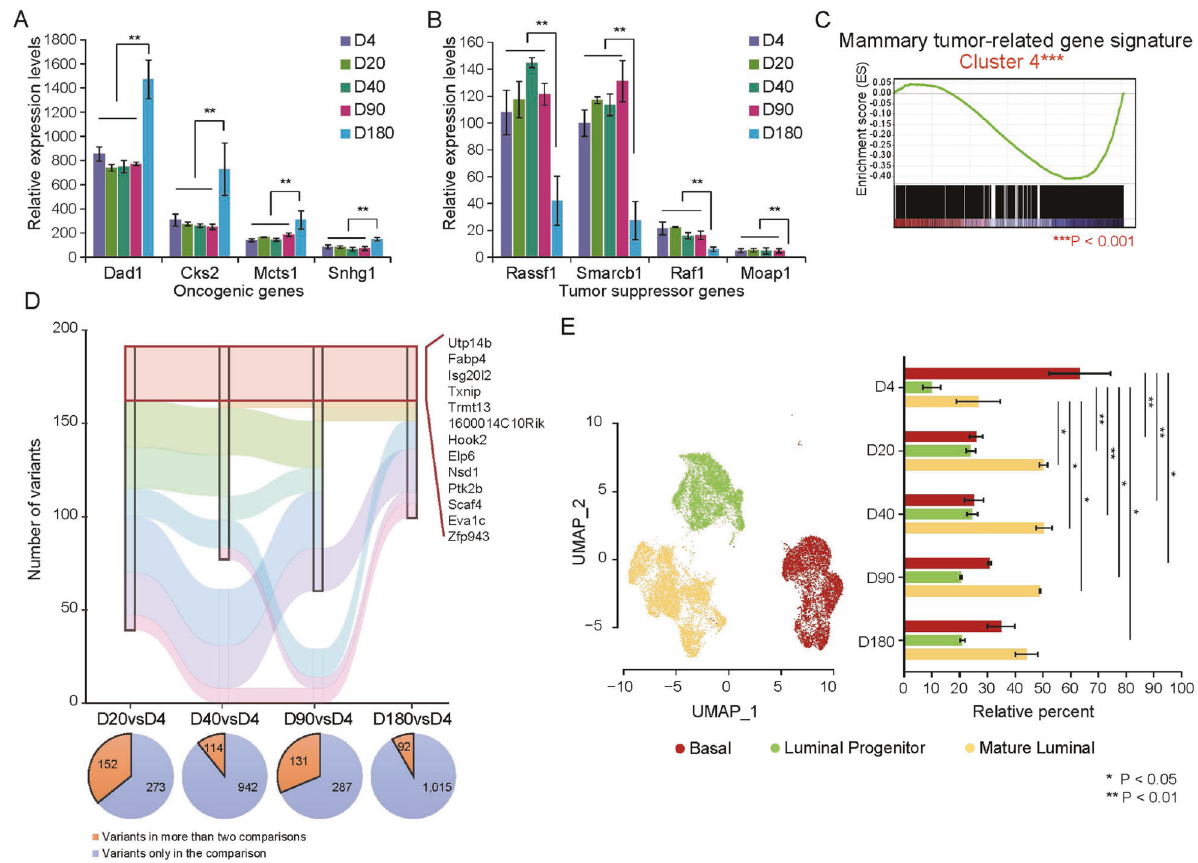
Fig. 7 Mammary gland tumor-related gene expression signature. A , B Increased expression of the representative oncogenes including DAD1, CKS2, MCTS1, and SNHG1 ( A ), and decrease of tumor suppressor genes including RASSF1, SMARCB1, RAF1, and MOAP1 ( B ) at D180, compared to any younger time points. C GSEA analysis revealed that genes in Cluster 4 are signi fi cantly enriched in a mammary gland tumor- related gene signature derived from GSE130472. D Gene mutations at different time points compared to D4 were called by GATK and Varscan2. Sankey diagram showed the number of variants at different time points, in which different colors represent different mutation patterns. The frequency of mutations at each time point was indicated below the Sankey diagram. E Analysis using a cell type-based signature derived from GSE130472 (left panel) indicated the highest proportion of basal cells at D4. While both luminal progenitor and mature luminal cells showed the lowest proportion at D4, and maintained at a high level from D20 to D180 (right panel). DEG differentially expressed gene. Data are presented as the mean ± SEM ( n = 3). * p < 0.05, ** p < 0.01, *** p <